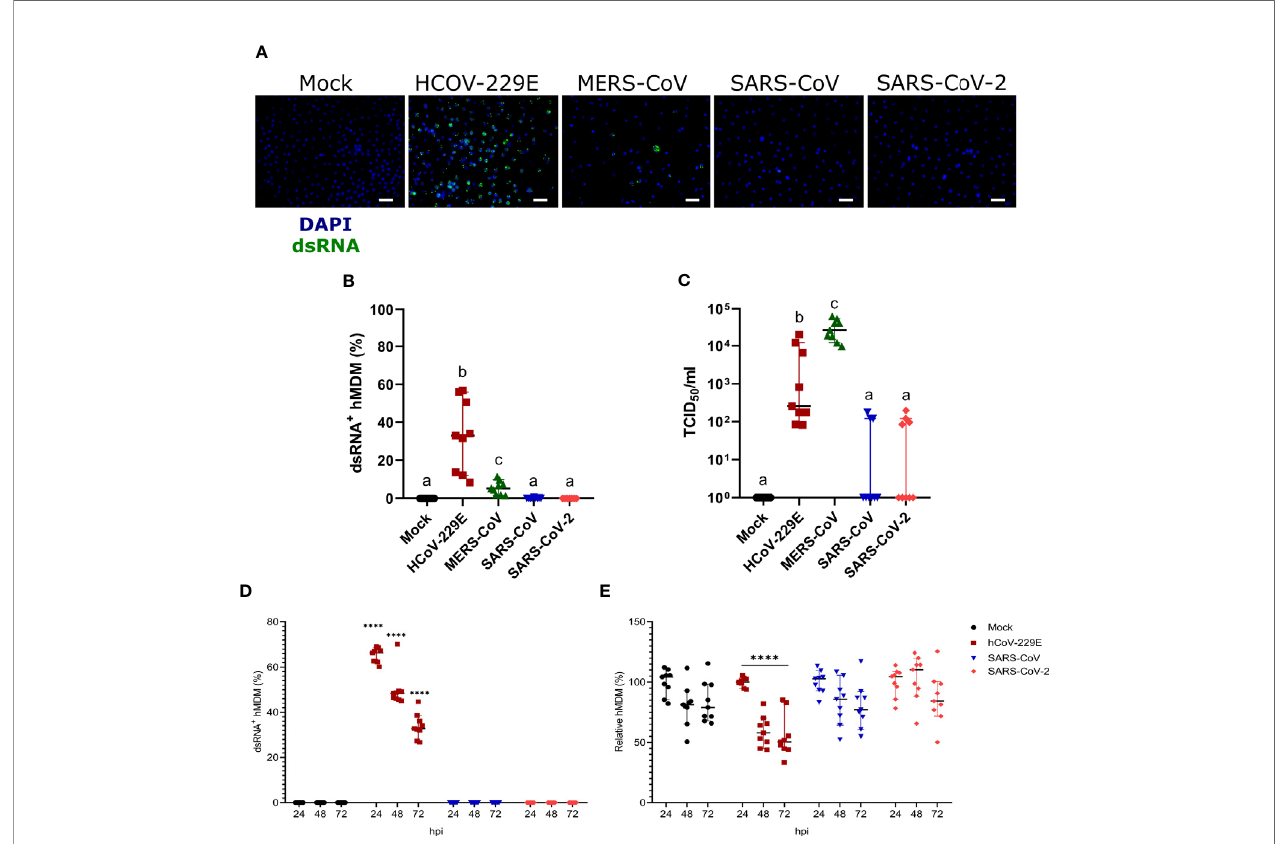
FIGURE 2 | Susceptibility of hMDM to different human coronaviruses. Human MDM were inoculated with different coronaviruses (hCoV-229E, MERS-CoV, SARS- CoV-1 and SARS-CoV-2) using an MOI of 1 TCID 50 /cell. Mock-infected cells were included as controls. After incubating the cells for 1.5 hours, the inoculum was removed, the cells washed, and fresh medium added. At 24 hpi, dsRNA in the cells was detected with a speci fi c antibody and nuclei were stained with DAPI; the scale bar represents 40 µm. (A) The percentage of dsRNA-positive hMDM was calculated for 10 fi elds per condition (B) . In (C) virus titers are shown. The same experiment was repeated with hCoV-229E, SARS-CoV-1 and SARS-CoV-2, and infected cells were quanti fi ed at 24, 48 and 72 hpi (D) . The relative number of total hMDM per well was calculated taking as reference the number of cells at 24 hpi (E) . The data from three independent experiments run in triplicates are shown in each panel. Statistically signi fi cant differences between the conditions are indicated by different superscript letters in (B, C) (p < 0.05), and by asterisks in (D, E) (****p ≤